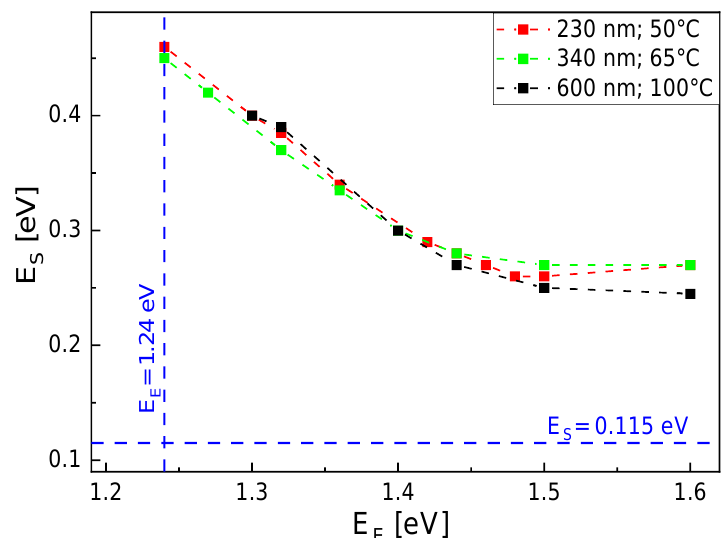
Figure 4. Pairs of E E and E S which yield simulated droplet numbers in agreement with the experimental values after deposition. The temperature is assumed to depend on the aperture diameter d as indicated. The dashed blue lines indicate the activation energies obtained for self-assembled droplet formation.